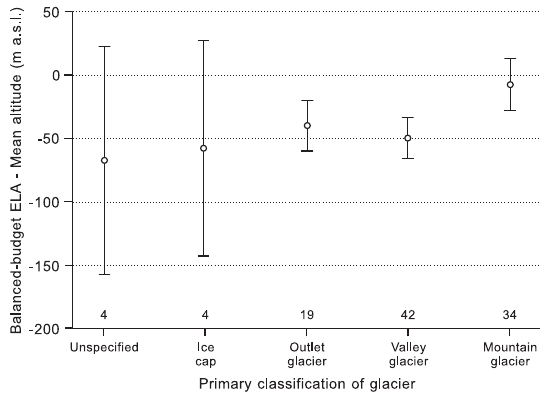
Figure 8. Box plot of mean balanced-budget ELA minus Kurowski mean altitude (ELA 0 – H mean ) vs. primary classification of glaciers. Error bars represent 95% confidence intervals of the means accord- ing to Student’s t -statistic. Number of glaciers in each group are given in the lower part of the